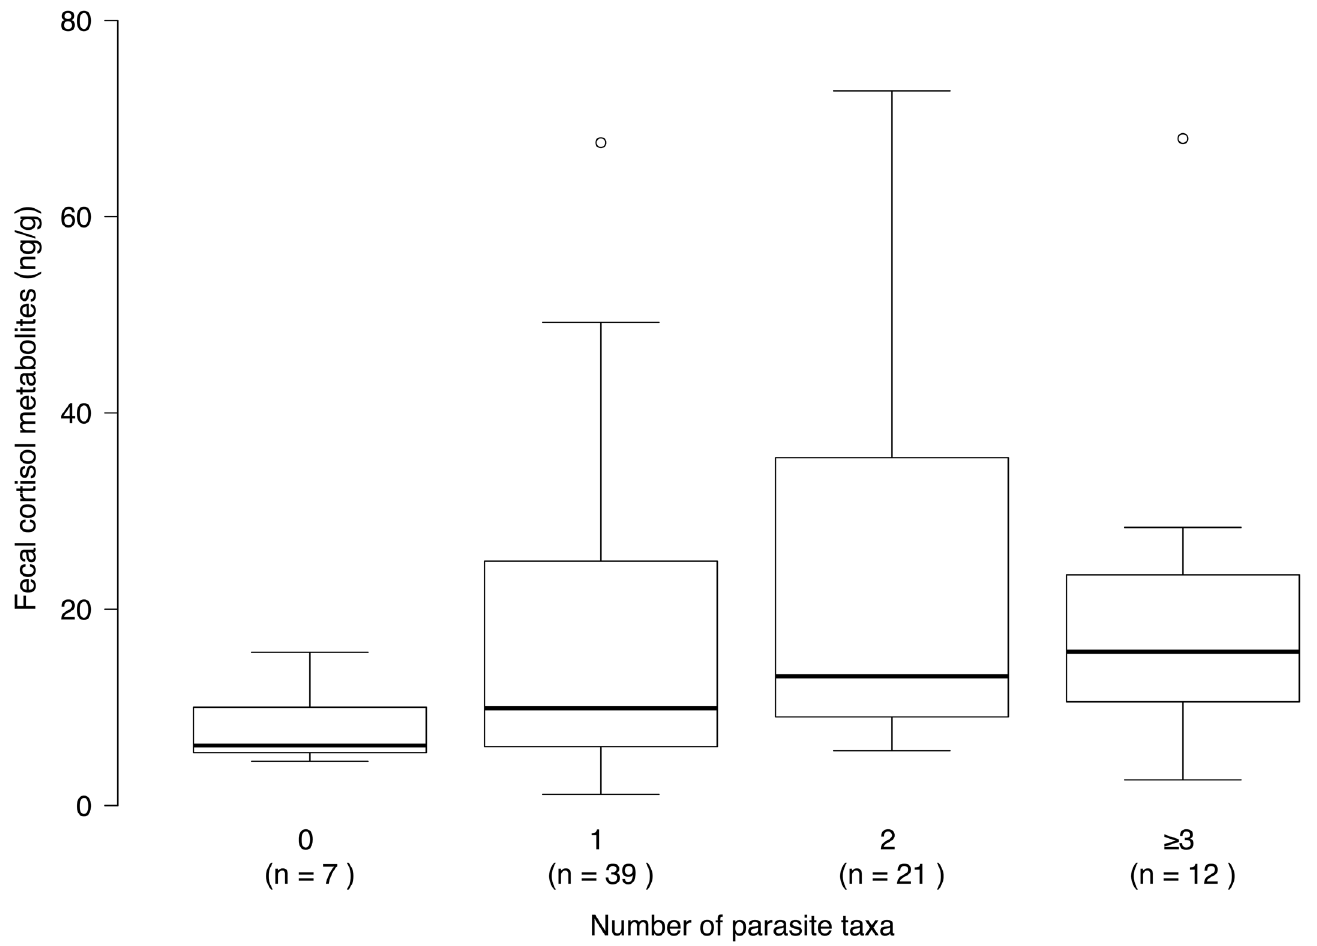
Fig 4. Concentrations of cortisol metabolites and detected number of parasite taxa in wolf fecal samples collected in Abruzzo Lazio e Molise National Park (Italy), from October 2006 to March 2007. Box and whisker plots show median (horizontal line within box), 25% and 75% percentiles (box), range (whiskers) and statistical outliers (open circles). For clarity, outliers above 80 ng/g are not